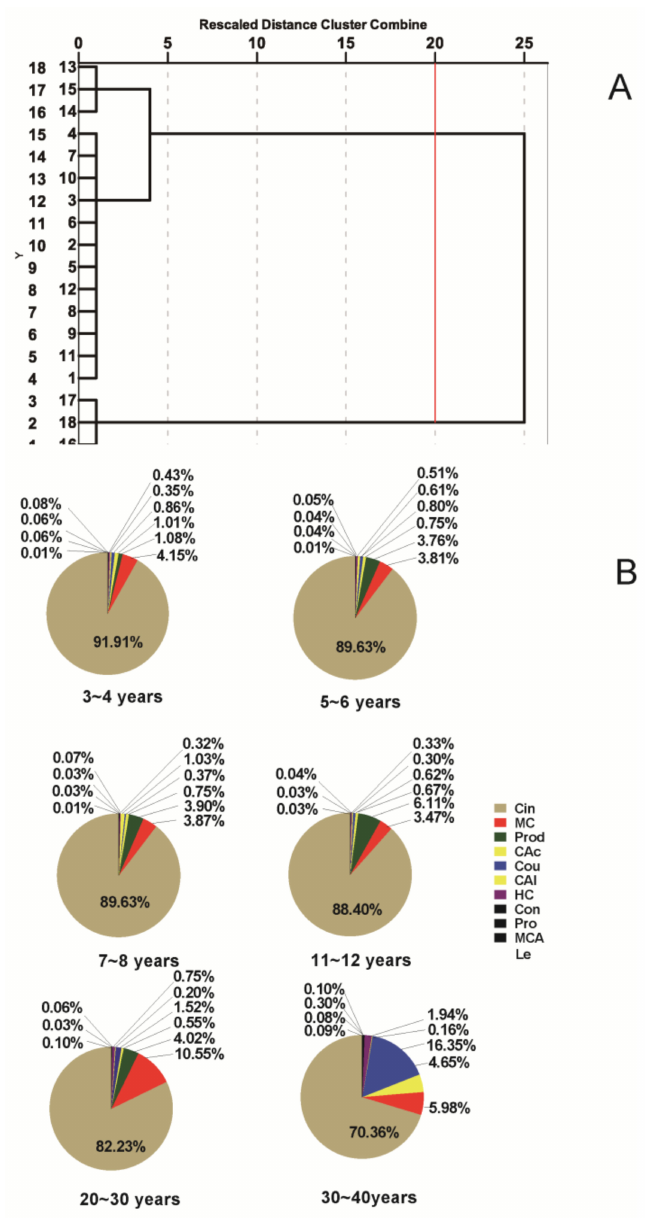
Figure 6. Dendrograms of HCA ( A ) of CC at different growth stages and abundance ( B ) of phenylpropanoids and phenolics in CC at different growth